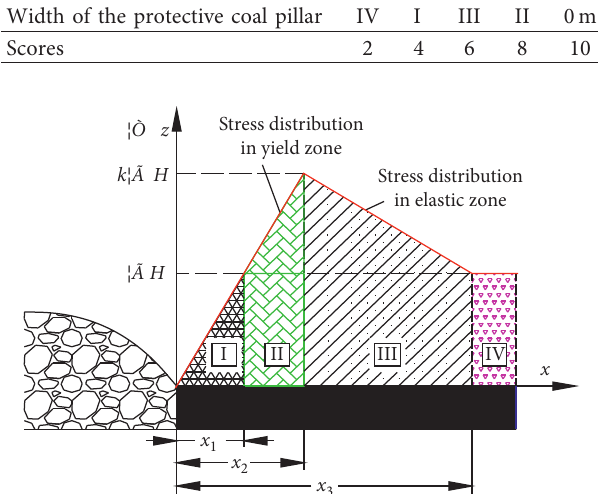
Figure 3: Stress redistribution on the solid coal along the gob [20] (I: destressed yield zone ( 0 < x ≤ x ) , III: overstressed elastic zone ( x < x ≤ x zone, ( x 1 2 IV: premining vertical stress zone ( x > x